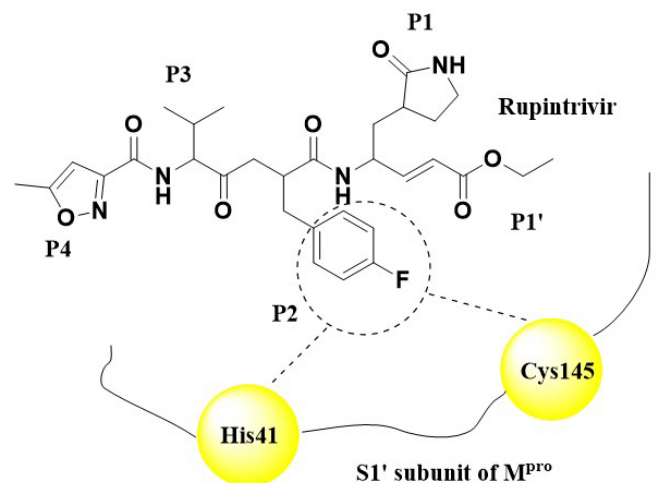
Figure 4. Catalytic interaction of rupintrivir with S1 subunit of M pro of